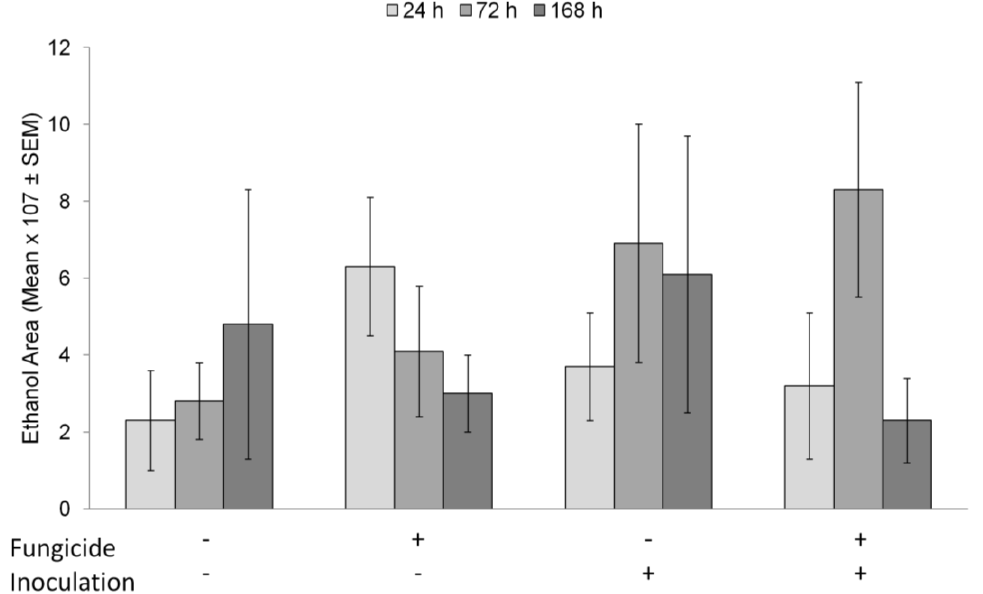
Figure 4. Ethanol emission (±SEM) from trees at 24, 72, and 168 h of flooding. Fungicide+ = plants treated with Pageant ® Intrinsic ® ; Inoculation+ = plants inoculated with P. cinnamomi . Bars with different letters are significant at p < 0.05 by Scheffe pair-wise comparison.